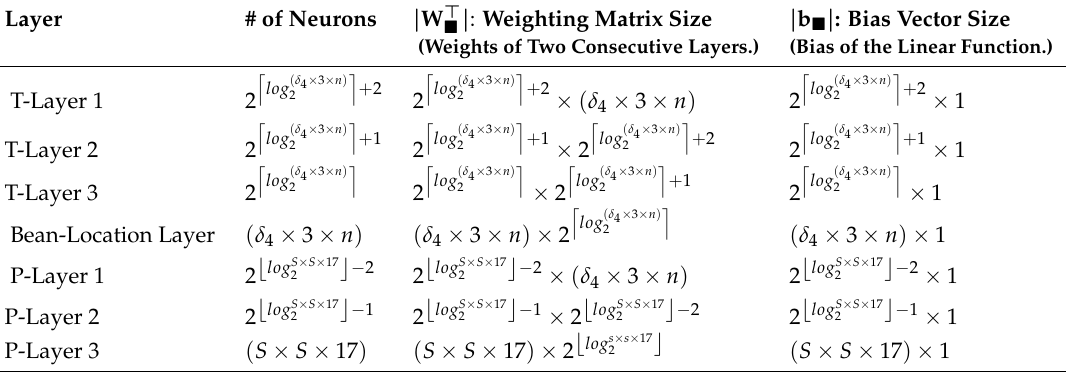
Figure 7. The structure and workflow of the generative-adversarial network (GAN)-based data augmentation framework. Table 2. Profile of the bean-shifting deep network structure in this